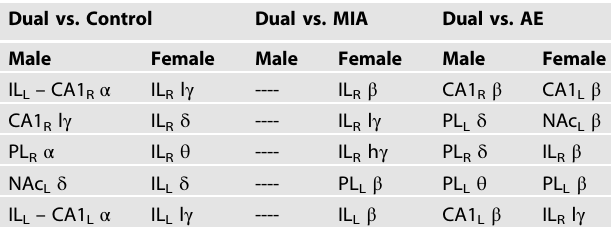
Table 1. The neural features containing the most information for each of the models that performed above chance estimates.